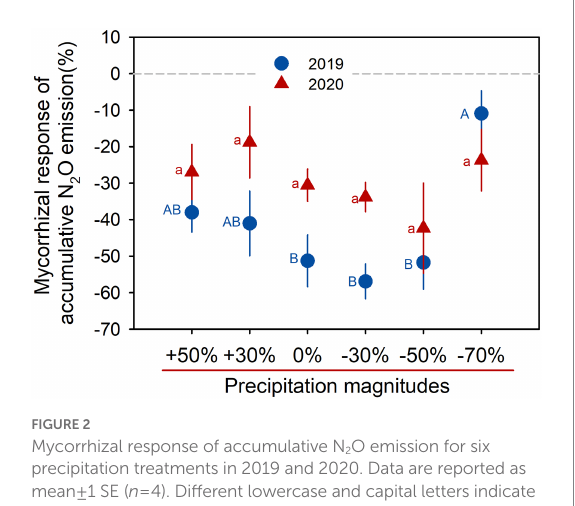
FIGURE 2 Mycorrhizal response of accumulative N 2 O emission for six precipitation treatments in 2019 and 2020. Data are reported as mean ± 1 SE ( n = 4). Different lowercase and capital letters indicate significant differences ( p < 0.05) among the precipitation treatments in 2019 and 2020,